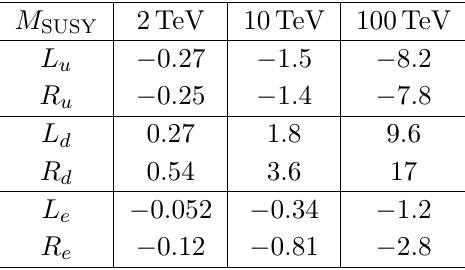
in 10 (cid:0) 3 unit for each case of M SUSY 13